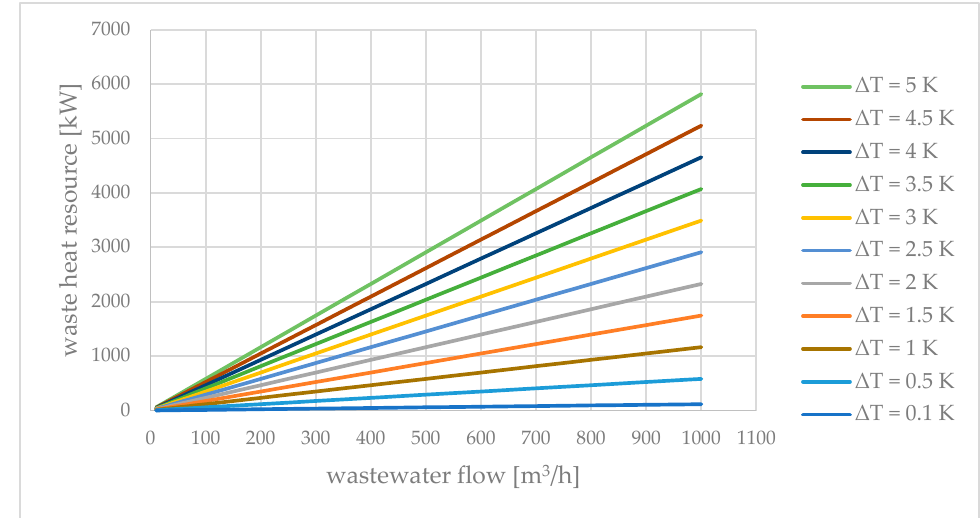
Figure 4. Available waste heat resource.